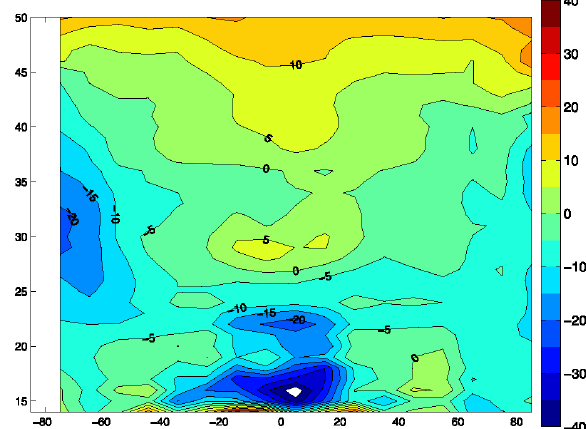
Fig. 24. Ozone mixing ratio yearly mean from GOMOS night time occultations only. Polar areas are not sampled during the summer and only the region 50 S to 50 N are sampled over the whole year. Fig. 25. Median of the relative difference (in%) between GOMOS ozone mixing ratio and the F-K climatology in 2003. The contours are separated by 5%. The horizontal axis is latitude in degrees, and the vertical axis is altitude inkm (from Kyr¨ol¨a et al.,